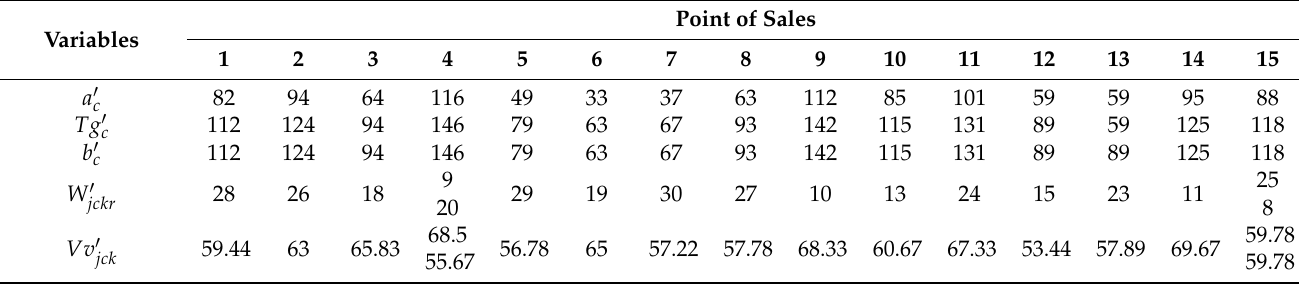
Figure 8. Results obtained in the second scenario. Table 5. Second scenario: arrival time, trip assignment, and travel speed for the arc ( j,c ).